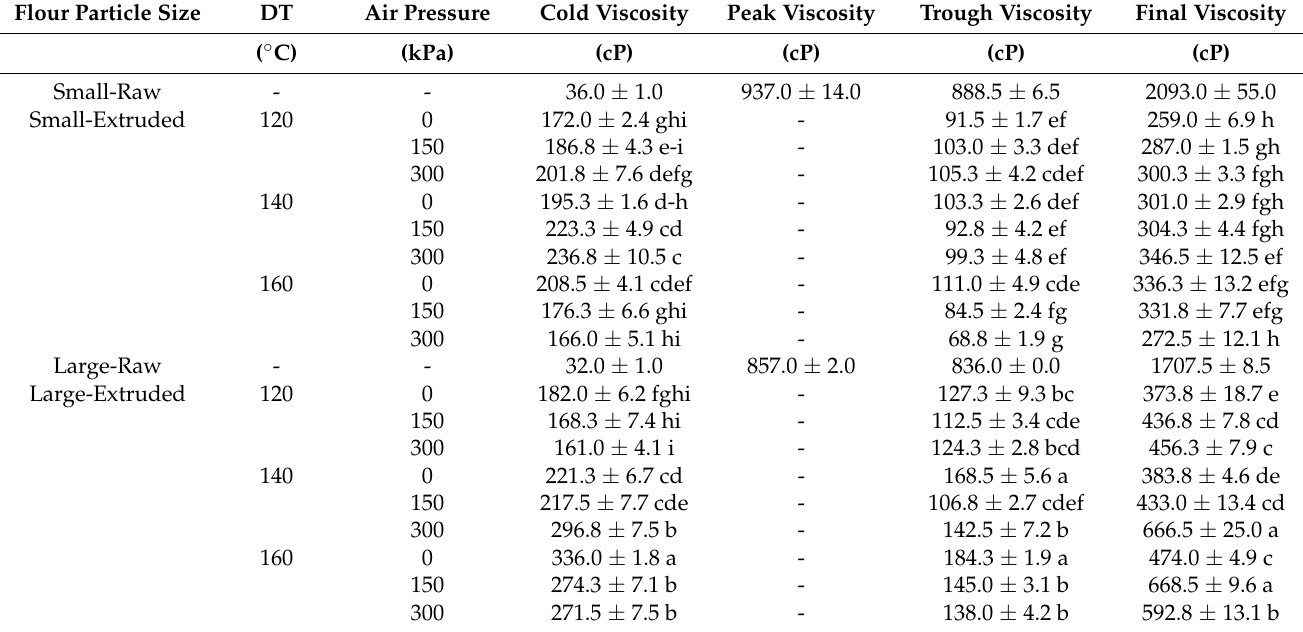
Table 4. Pasting properties of raw and extruded yellow pea flours as a function of flour particle size, die temperature (DT) and air injection